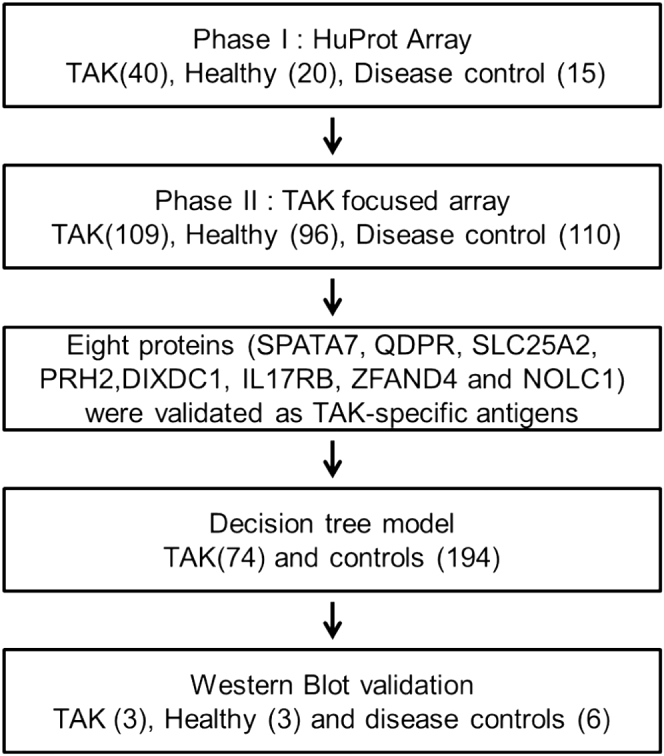
Flow chart of the overall study design.